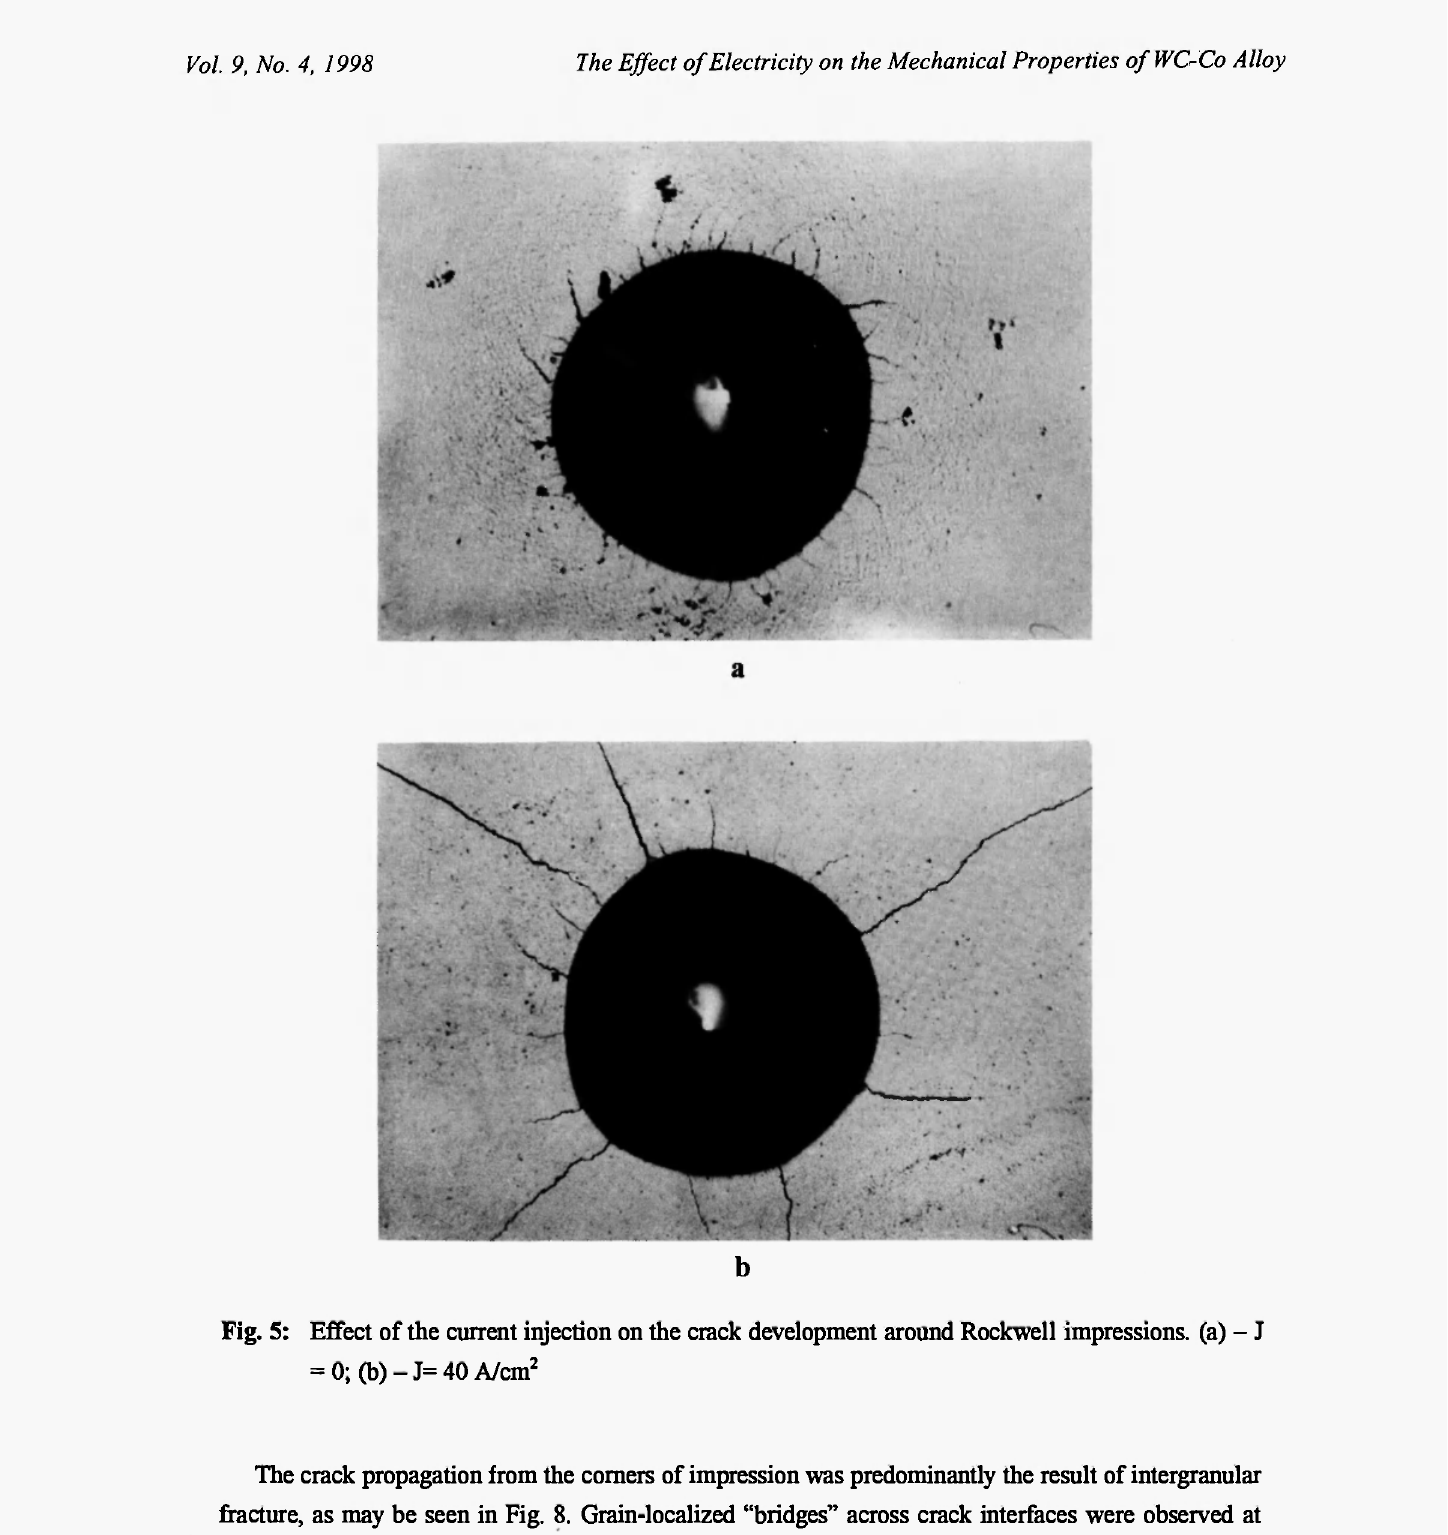
b Fig. 5: Effect of the current injection on the crack development around Rockwell impressions, (a) - J = 0; (b) - J= 40 A/cm 2